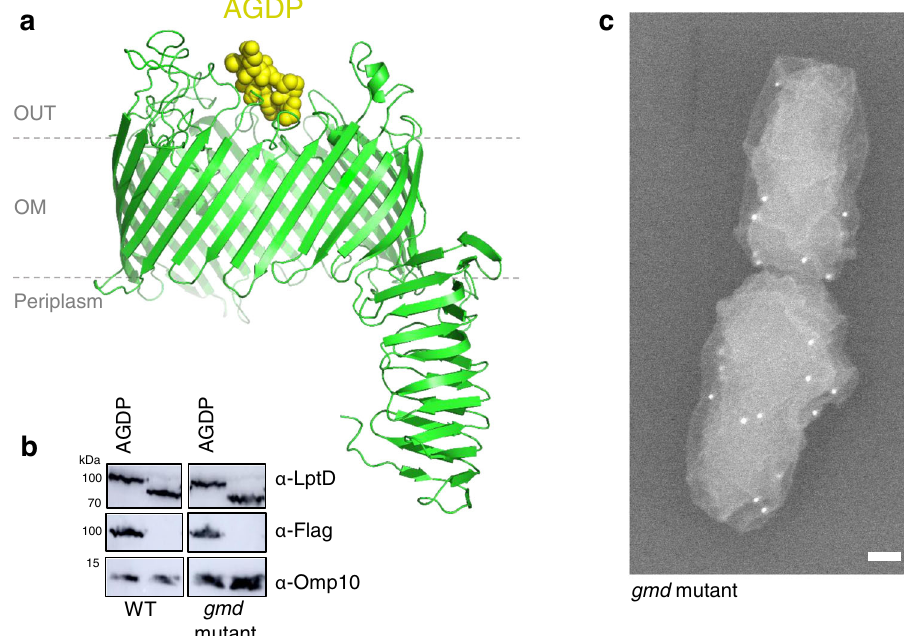
α -Flag antibody. All the WB were performed in triplicates with similar results. Source data are provided as a Source Data fi le. c Representative scanning electron microscopy picture for one replicate of gmd mutant with 3Flag::lptD fusion. 3Flag- LptD was detected using a mAb against 3Flag, followed by secondary antibody coupledwith goldparticles, each white focus corresponds to a singlegoldparticle withtheexpectedsize(18nm)( n =3).Scalebarrepresents100nm.Sourcedataare provided as a Source Data fi